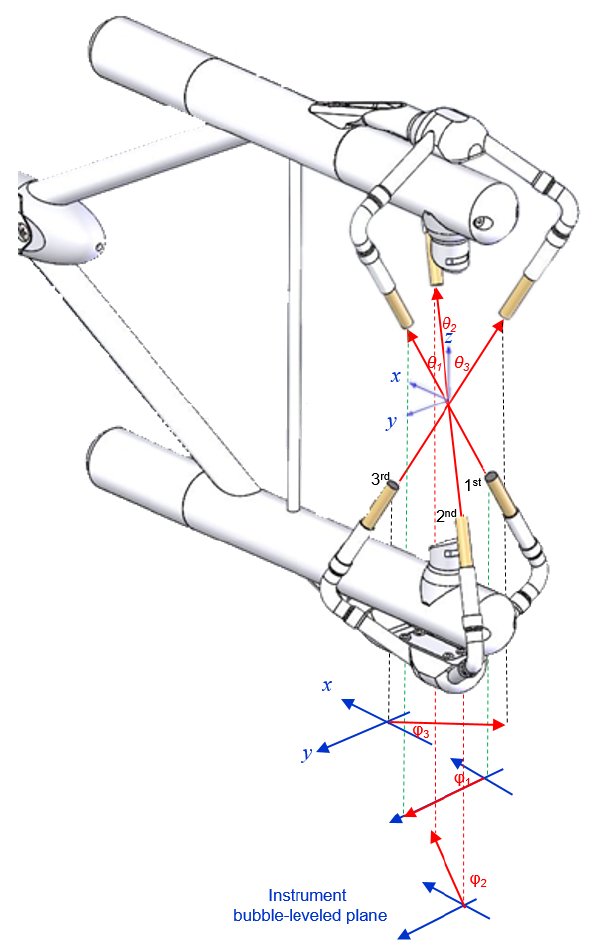
Figure A1. IRGASON sonic path angle geometry in the three- dimensional right-handed anemometer coordinate system of x , y , and z . Blue arrows are coordinates; a red arrow between a pair of sonic transducers is the sonic path vector whose direction is defined for air flow direction, the red arrow below the IRGASON is the projection of the corresponding sonic path vector on the x – y plane, i.e., anemometer (instrument) bubble-leveled plane. As indicated by their subscript of 1, 2, or 3 for the first, second, or third sonic path, θ 1 , θ 2 , and θ 3 are their zenith angles and ϕ 1 , ϕ 2 , and ϕ 3 are their azimuth